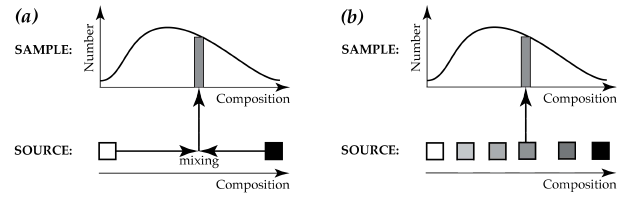
Fig. 7. Contrasting conceptions of mantle sources. (a) Generation of a sample by mixing material from two reservoirs before erup- tion. (b) Direct sampling of a heterogeneity of intermediate com- position. From Davies (2011). Copyright Cambridge University Press. Reprinted with